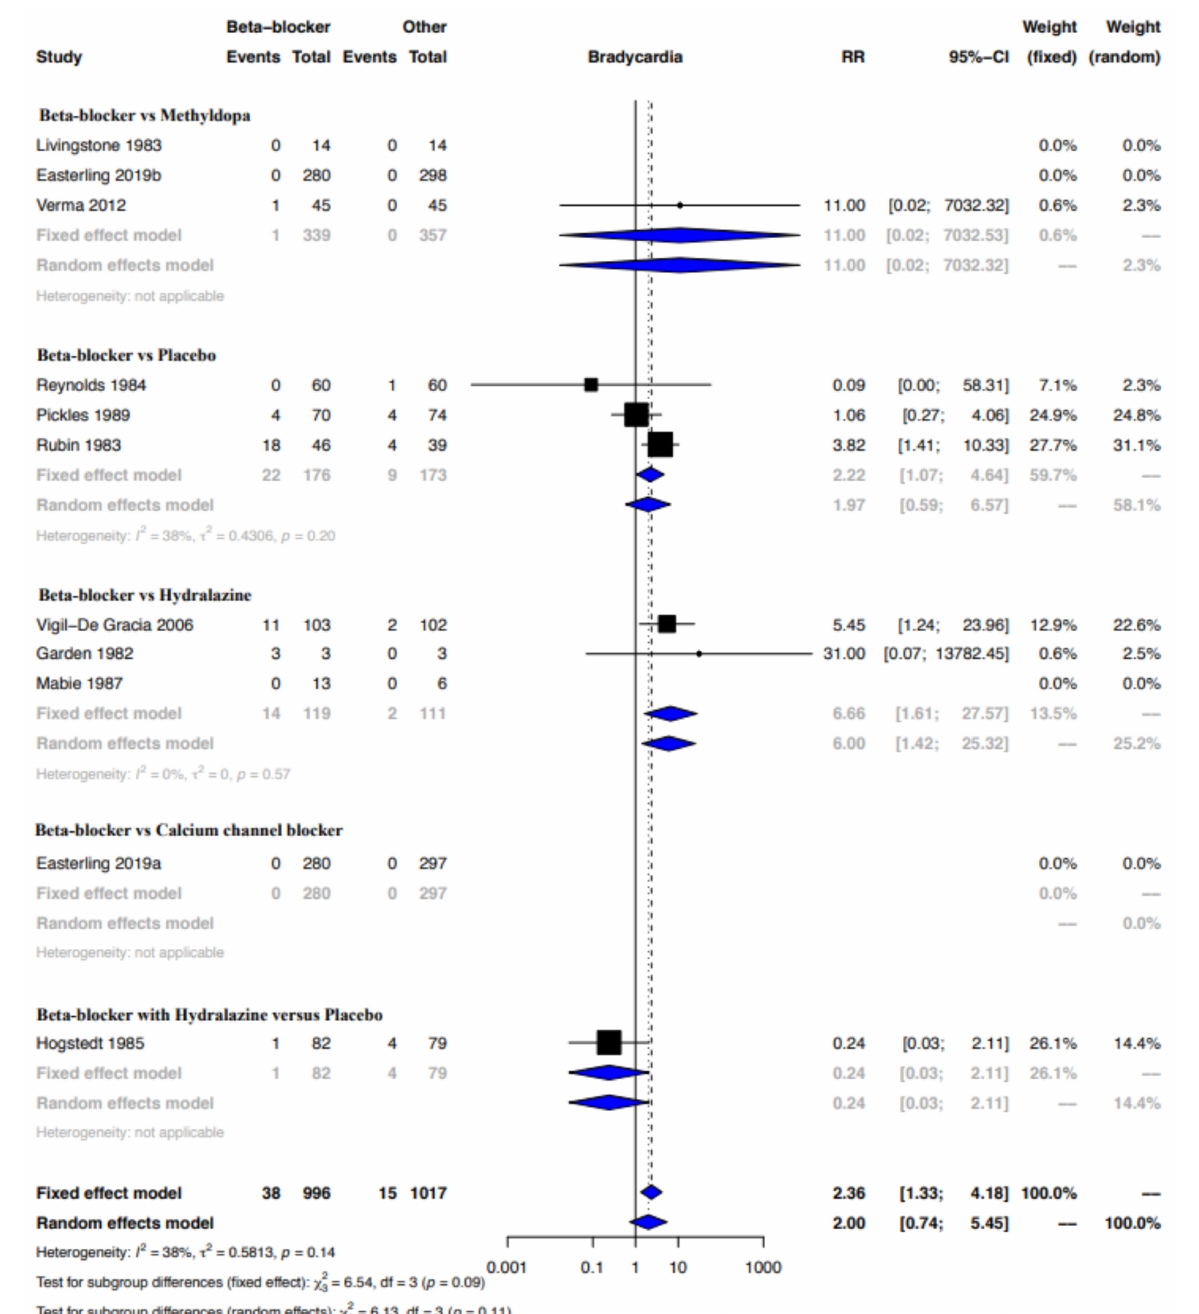
Figure 3. Meta-analysis bradycardia—RCT. Beta-blocker vs. methyldopa: [27,33,38]; beta-blocker vs. placebo: [45,51,53]; beta-blocker vs. hydralazine: [40,47,59]; beta-blocker vs. calcium channel blocker [33]; beta-blocker with hydralazine vs. placebo: